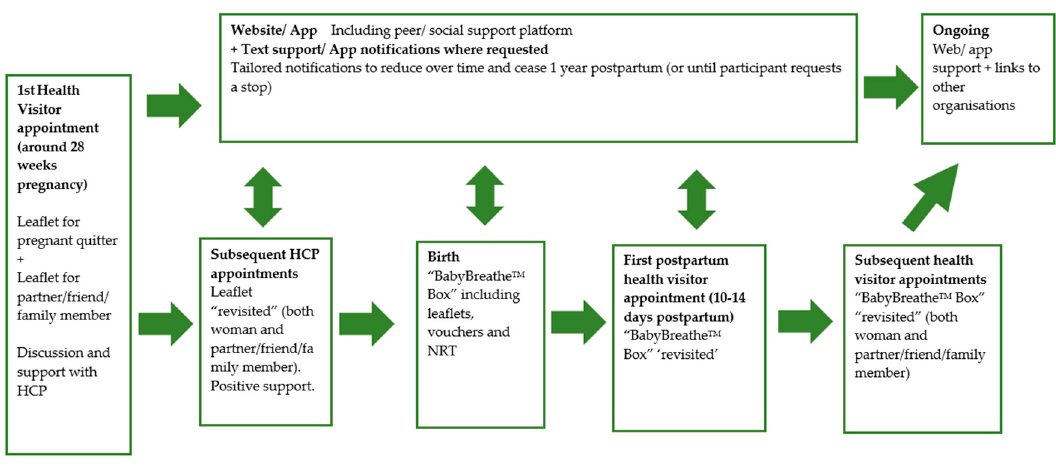
Figure 1. ‘BabyBreathe’ TM intervention pathway.